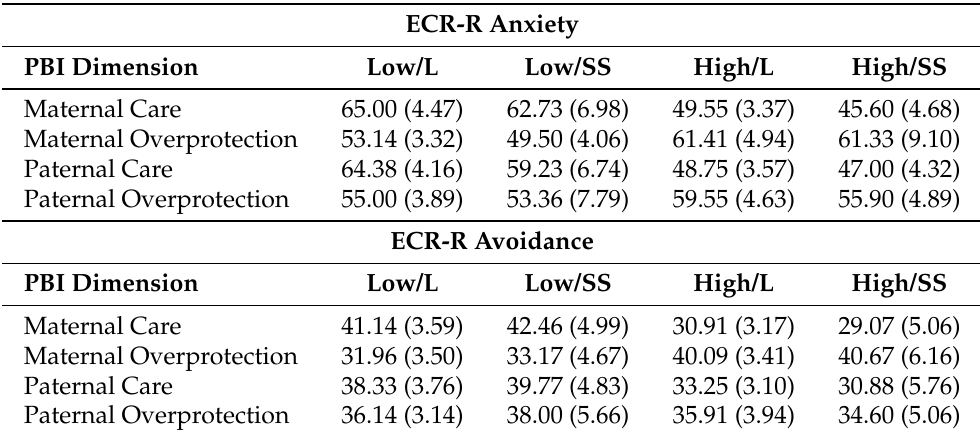
Table 4. Mean values in 5-HTTLPR L-carriers and S/S homozygotes by low and high PBI dimensions on ECR-R variables. Standard error means are reported between